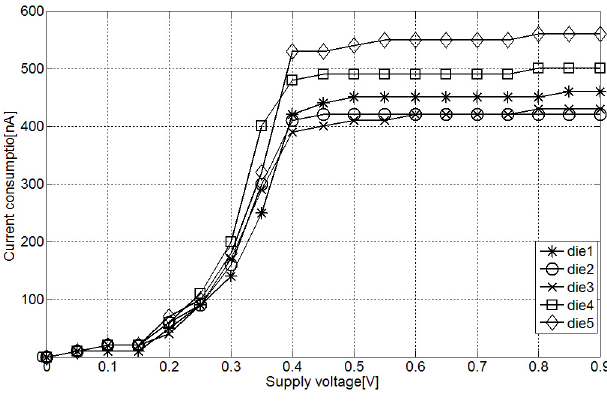
Figure 7. Measured DC current consumption at different supply voltages.